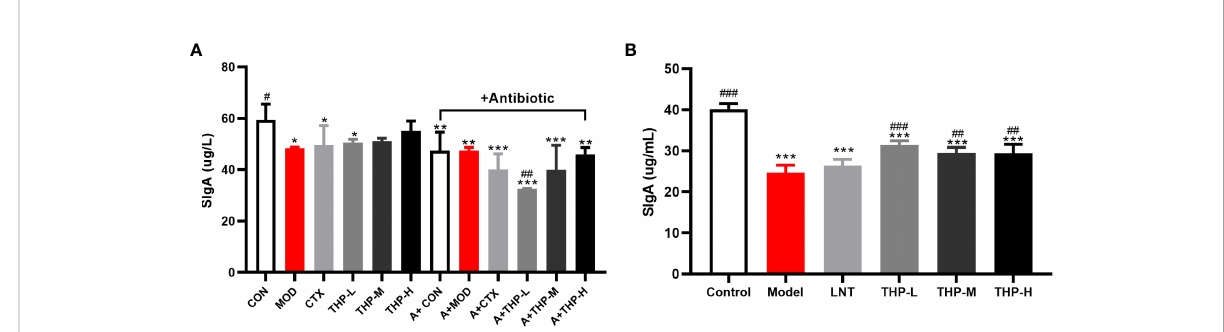
FIGURE 6 Effect of THP on the secretion of SigA in the intestinal tract. (A) SigA in Lewis tumor-bearing mice. (B) SigA in immunosuppressed mice. Each value is presented as the mean ± SD. *P < 0.05, **P < 0.01, ***P < 0.001 versus Control; # P < 0.05, ## P < 0.01, ### P < 0.001 versus